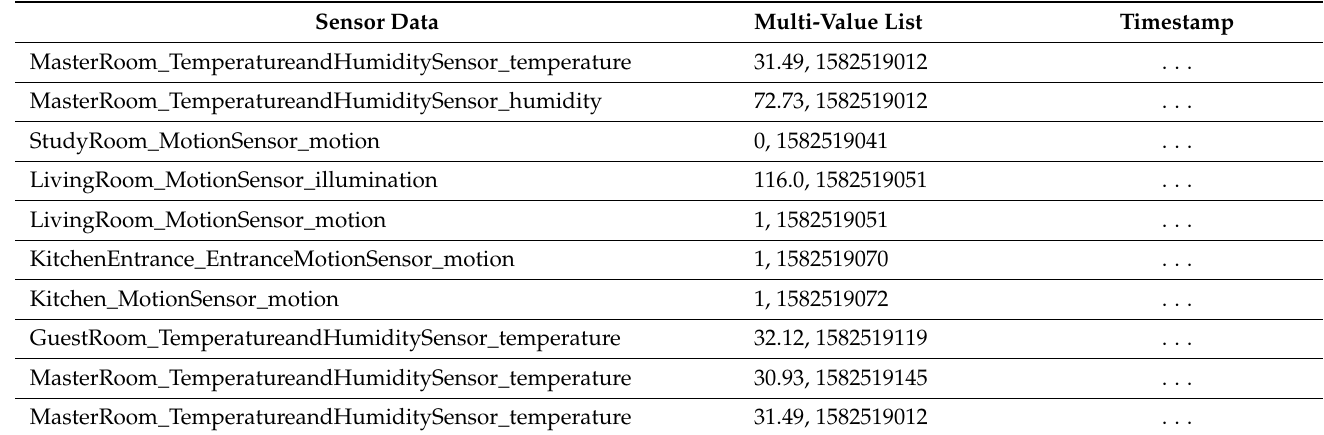
Table 3. Sample data collected from Apache